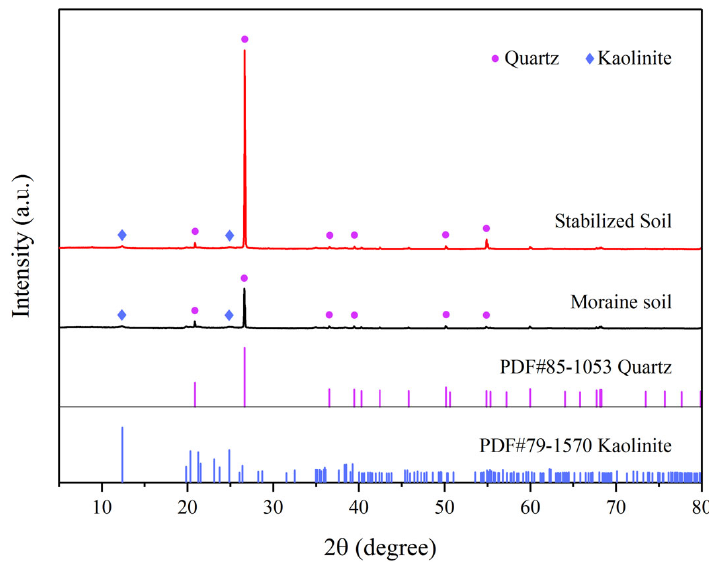
Figure 10. X ‐ ray diffraction patterns of glacial till and stabilized soil. Figure 10. X-ray diffraction patterns of glacial till and stabilized soil.